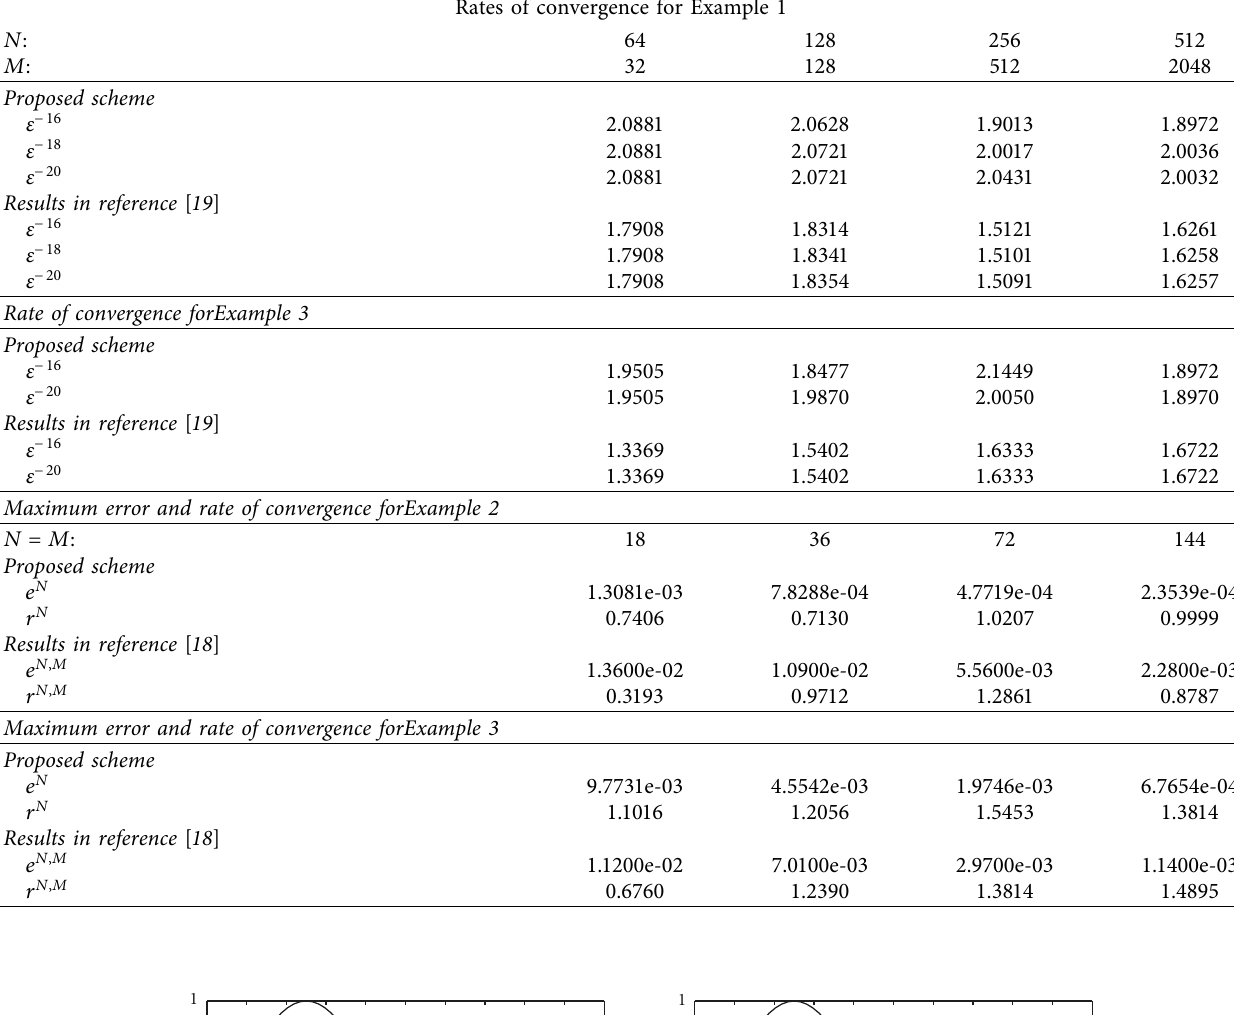
Table 4: Comparison of the proposed method with other published results in the literature.